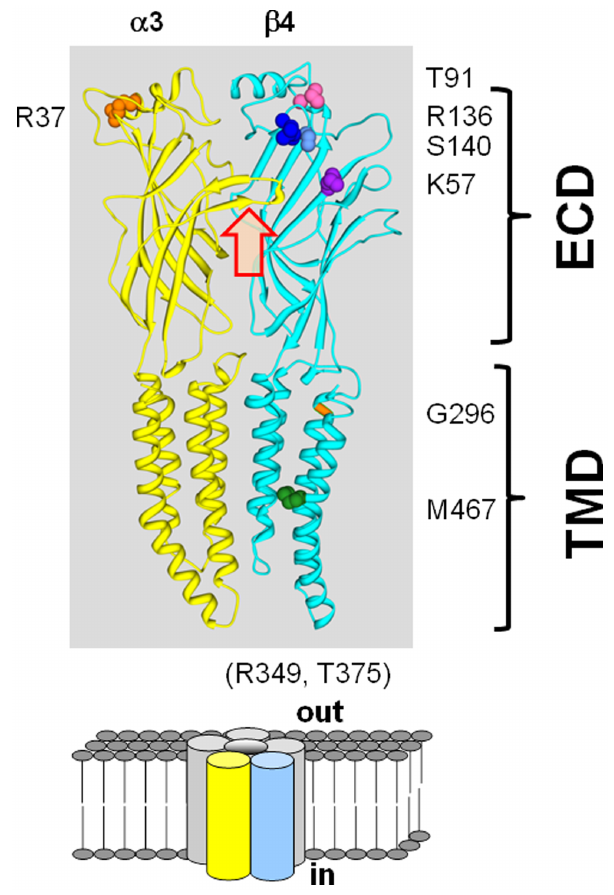
Figure 1. Locations of variants in a homology model of the a 3 b 4 receptor. The figure shows a homology model of the a 3 and b 4 subunits, generated using the GluCl crystal structure (see Methods). The view is from the outside of the pentamer (see lower panel for cartoon), and to simplify the image the 3 subunits on the far side of the channel have been omitted. The backbones are shown in ribbon form ( a 3 yellow, b 4 cyan). Locations of variants are shown as spheres colored as follows: in b 4(T91) pink, K57 purple, R136 dark blue, S140 light blue, G296 orange, M467 dark green. A variant described in the a 3 subunit ( a 3(R37)) is shown in orange on the a 3 subunit. The location of the ACh-binding site is indicated by the red block arrow (the site is formed at the a 3– b 4 interface). The brackets at the right indicate the extracellular domain (ECD) and the transmembrane domain (TMD). Note that the large intracellular loop is not present in the crystal structure and so the b 4(R349) and T375 residues are not shown.